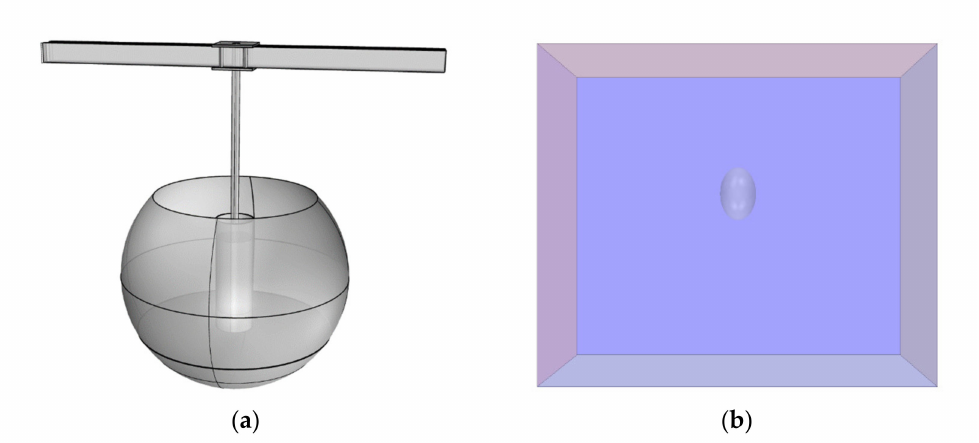
Figure 3. Model of C-TENG for hydrodynamic calculation. ( a ) Fixing device of the C-TENG; ( b ) calculation domain.